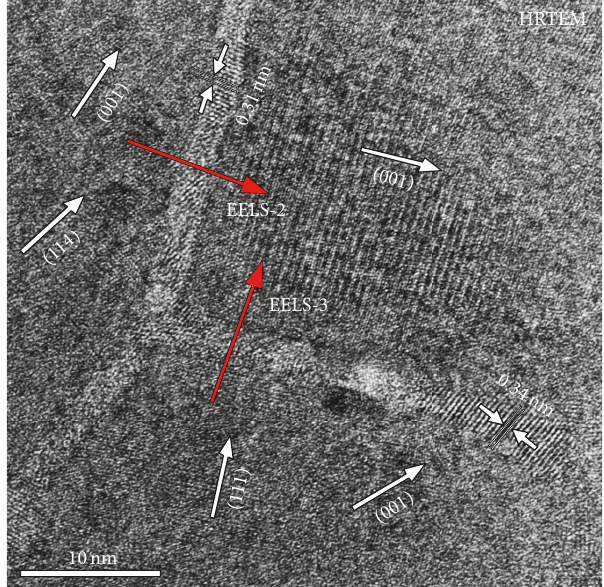
Figure 6: HRTEM image of three grains separated by crystalline GBs showing the (001) lattice fringes of the top right grain, (114) of the left grain, and (111) of the bottom grain are visible; the positions of the EELS line scans 2 and 3 of Figure 7 are shown.